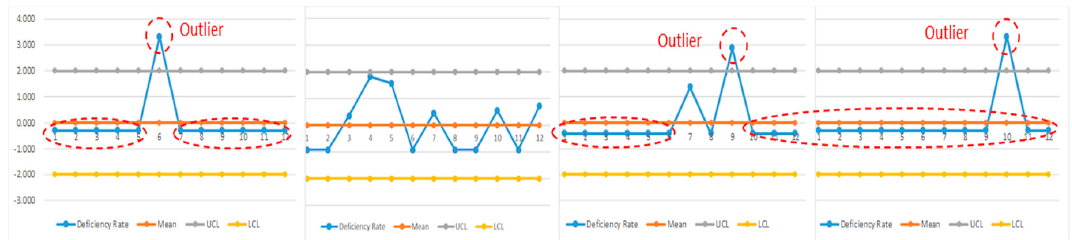
Figure 13. The control chart for deficiency 10 (2015–2018).